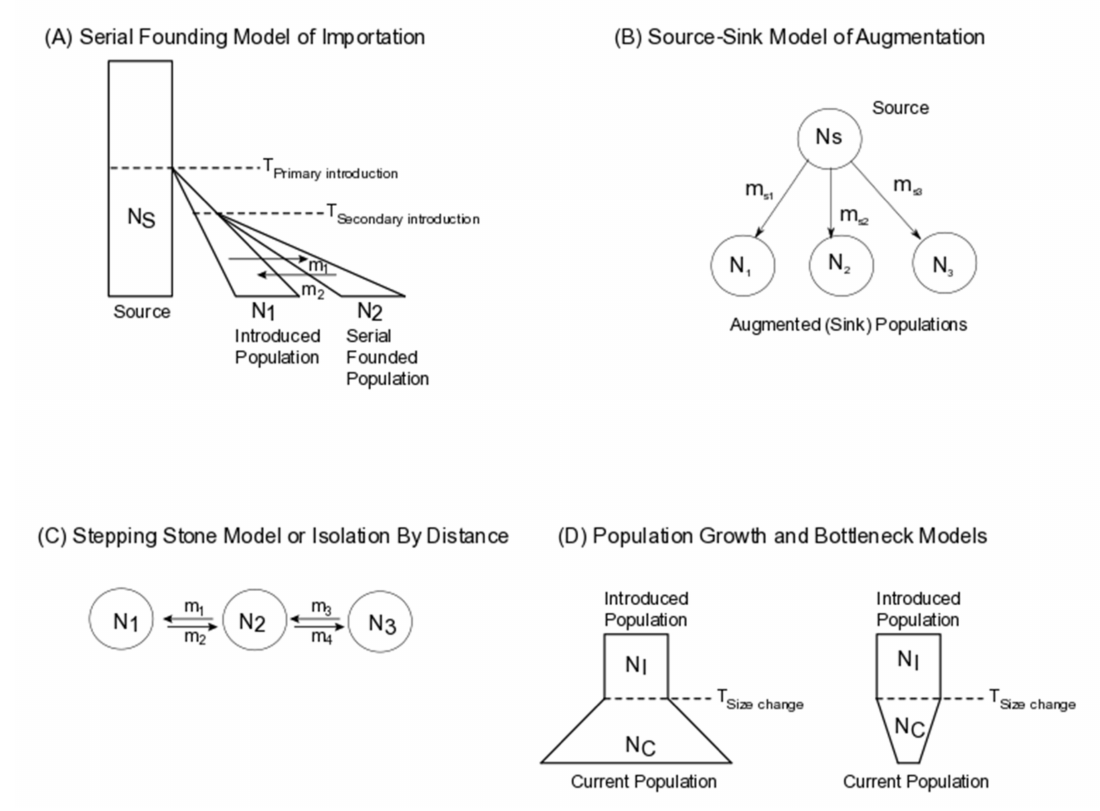
Figure1. Populationgeneticmodelsthatareusedtodescribeimportationandaugmentationofbiological control organisms—( A ) Serial founder model, often used to describe importation of biological control organisms, ( B ) Source-Sink model to describe augmentation, ( C ) Stepping stone model to describe establishment of new populations post-importation or augmentation, and ( D ) Population Growth and Bottleneck models to describe successful establishment or failure of importation and